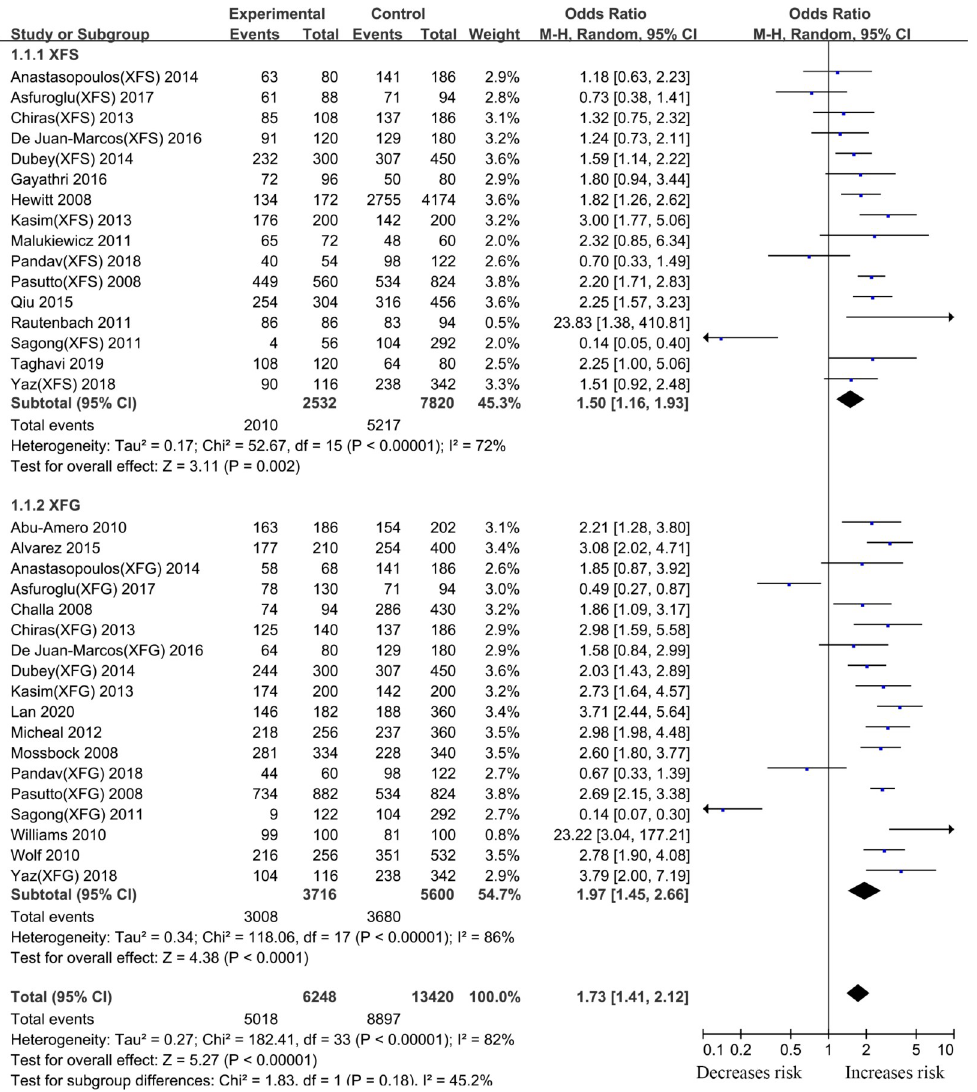
Fig 2. Meta-analysis for the association between exfoliation syndrome/exfoliation glaucoma risks and LOXL1 gene polymorphism rs1048661 (G vs. T): Subgroup analysis by disease types (squares depict individual studies and diamonds depict summary effect size estimates (Odds Ratio,